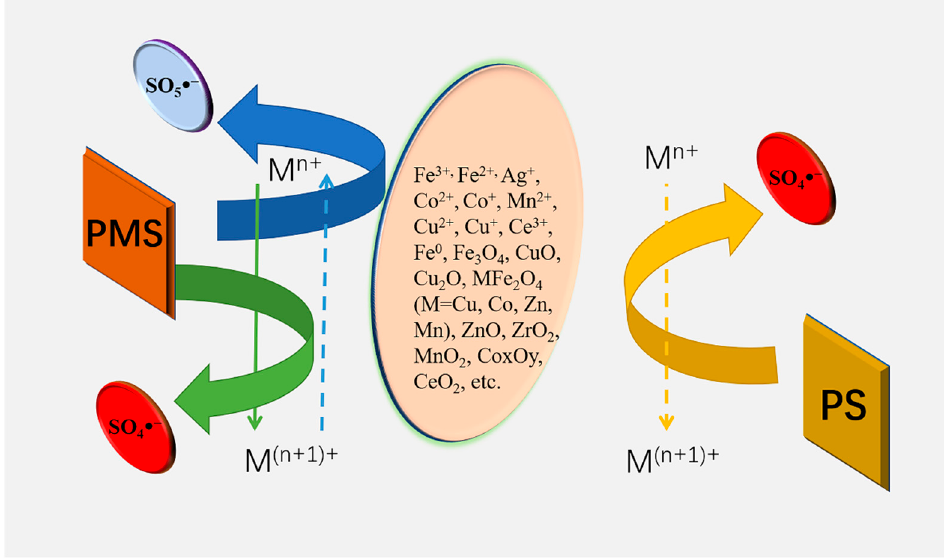
Figure 3. The mechanism diagram of PMS and PS activation by metal ions and metal oxides